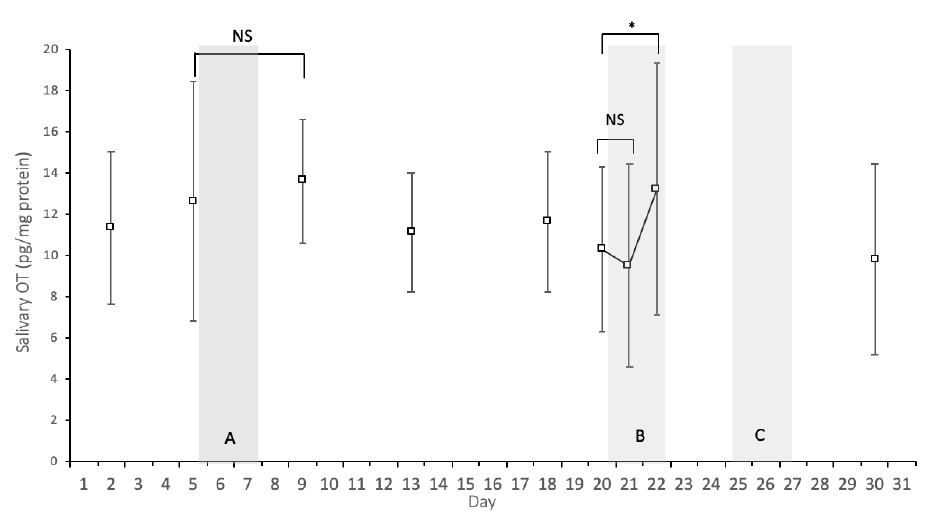
Figure 1. Mean (SD) salivary oxytocin (OT) before and after the solo bushcraft survival challenge (A) and the team-based bushcraft survival challenge (B). Notes: * = p < 0.05; NS = p ≥ 0.10; (C) is where 60 km expedition was held.